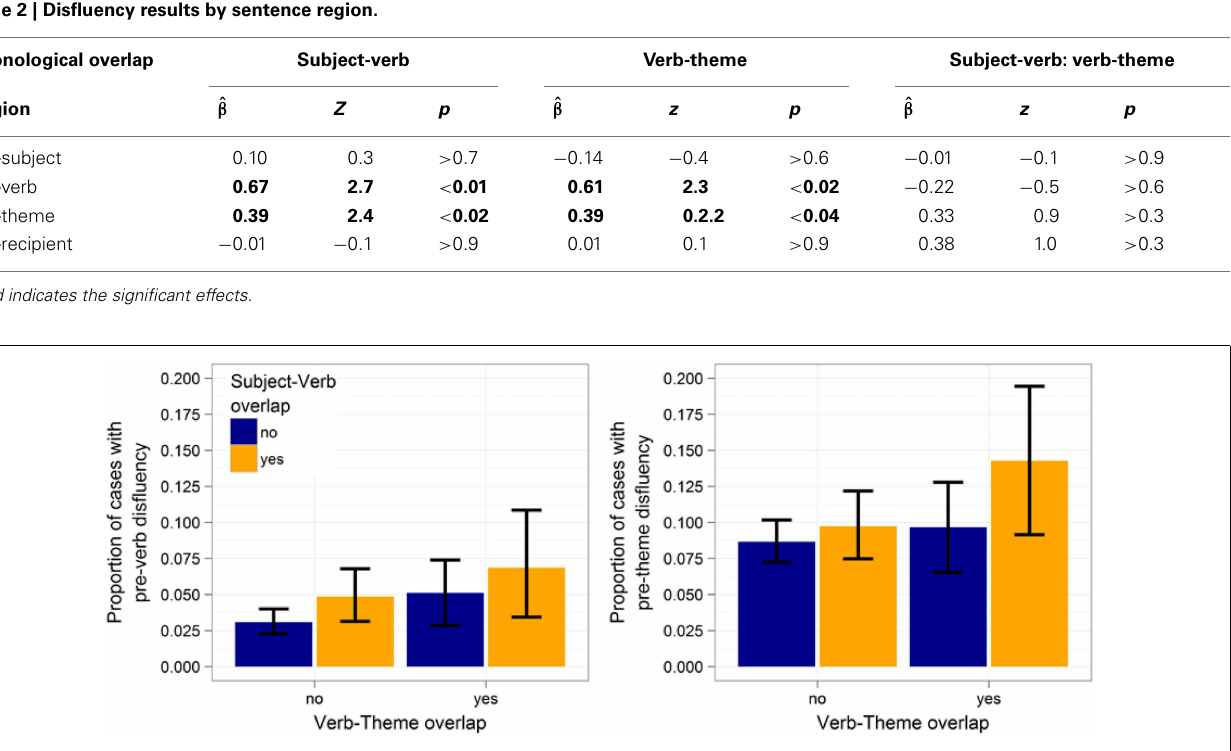
phonological encoding of the verb, in which case no effect